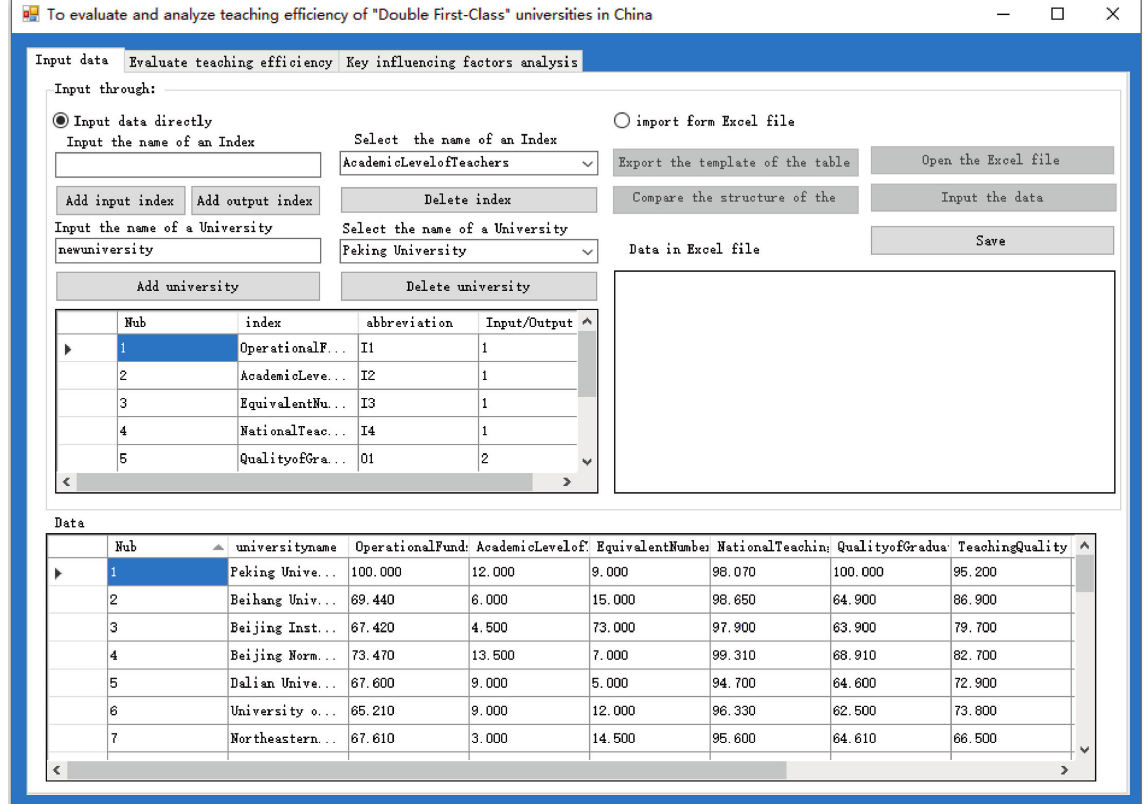
Figure 2: Interface for inputting